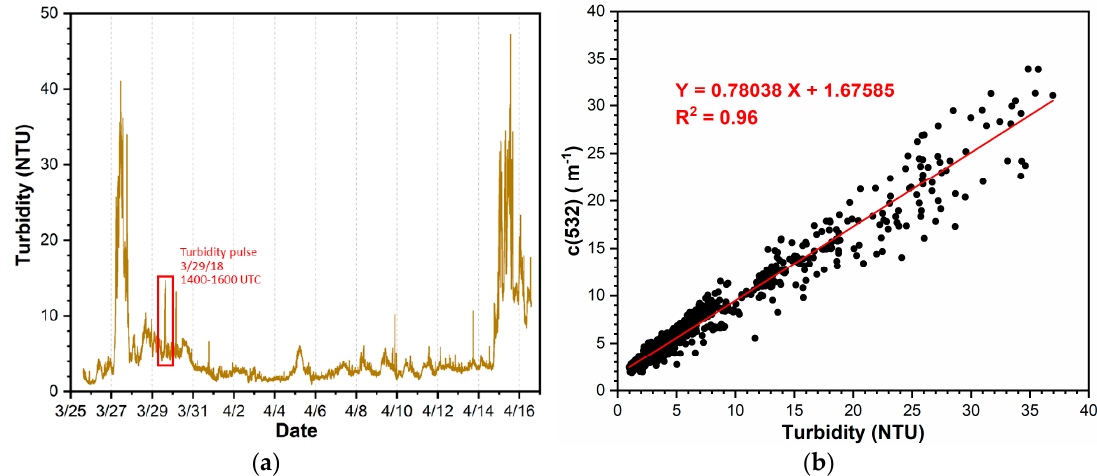
Figure 5. ( a ) Turbidity time series from mooring LM1, surface node. The red box indicates the 2-h turbidity pulse shown in more detail in Figure 6; ( b ) Beam attenuation coefficient at 532 nm, c(532), vs. turbidity. Red line and equation depict the least-squares linear regression best-fit, and coefficient of determination, R 2 .